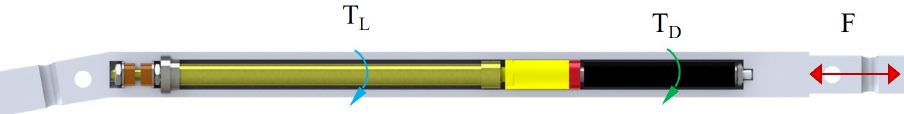
Figure 5. The schematic of the relationship between T L , T D , and F